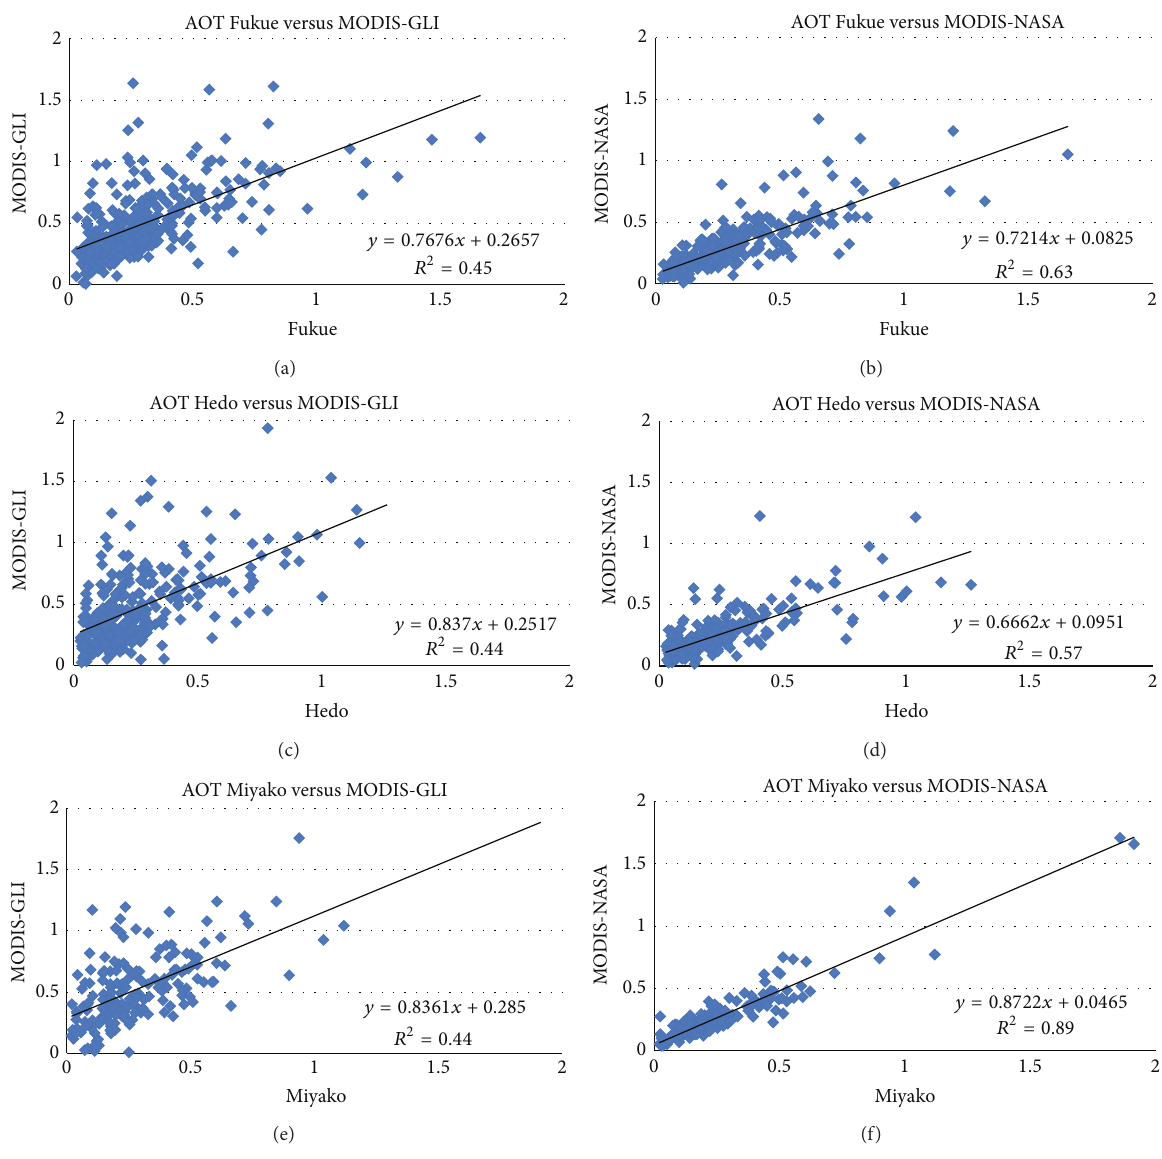
Figure 2: Scatter diagrams between ground (Fukue, Hedo, Miyako) and satellites’ derived aerosols AOT. Ground data are on the 𝑥 -axis while satellite derived data (from both algorithms, MODIS-GLI and MODIS-NASA) are on the 𝑦 -axis. AOT is the aerosol optical